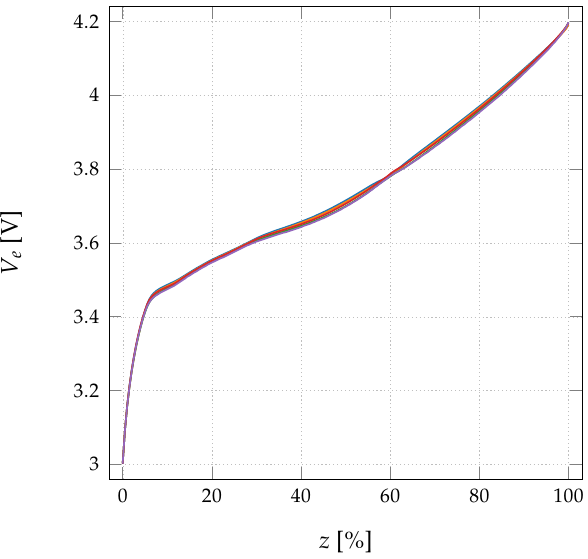
Figure 8. Comparison of the SoC-V e relation identified from five different batteries in the same production